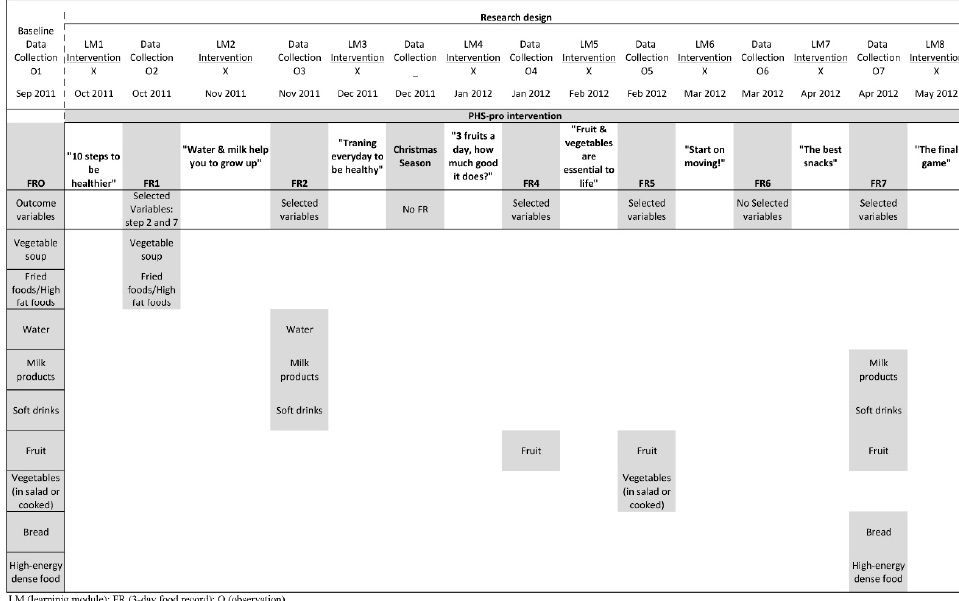
Figure 1. Research design and analysed variables according the learning modules’ goals.